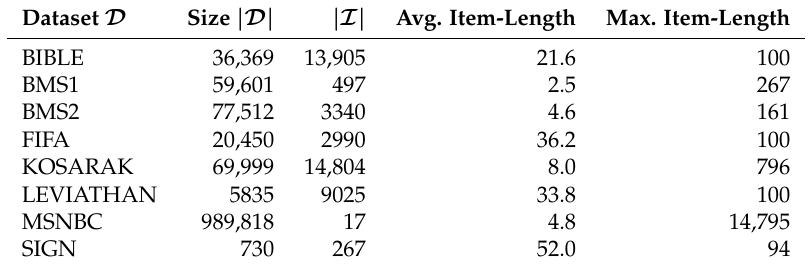
Table 1. Datasets characteristics. For each dataset D , we report the number |D| of transactions, the total number |I| of items, the average transaction item-length and the maximum transaction item-length. Dataset D Size |D| |I| Avg. Item-Length Max.